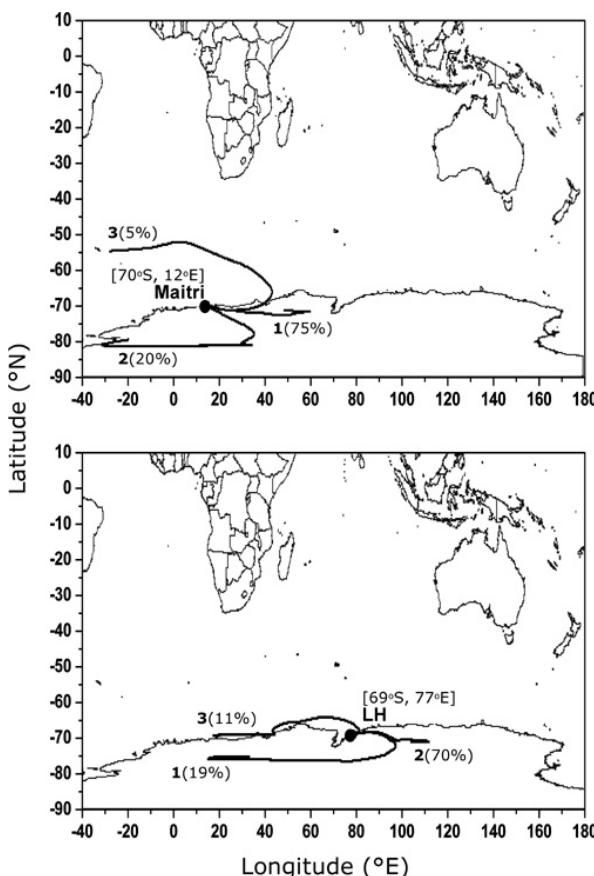
Fig. 3. The cluster mean of the 7 days HYSPLIT airmass back trajectories over Indian Antarctic stations, Maitri and LH for the entire summer and autumn season (1 December 2007 to 31 March 2008). The percentage contribution of the number of trajectories in each cluster to the total number of trajectories at each location is also